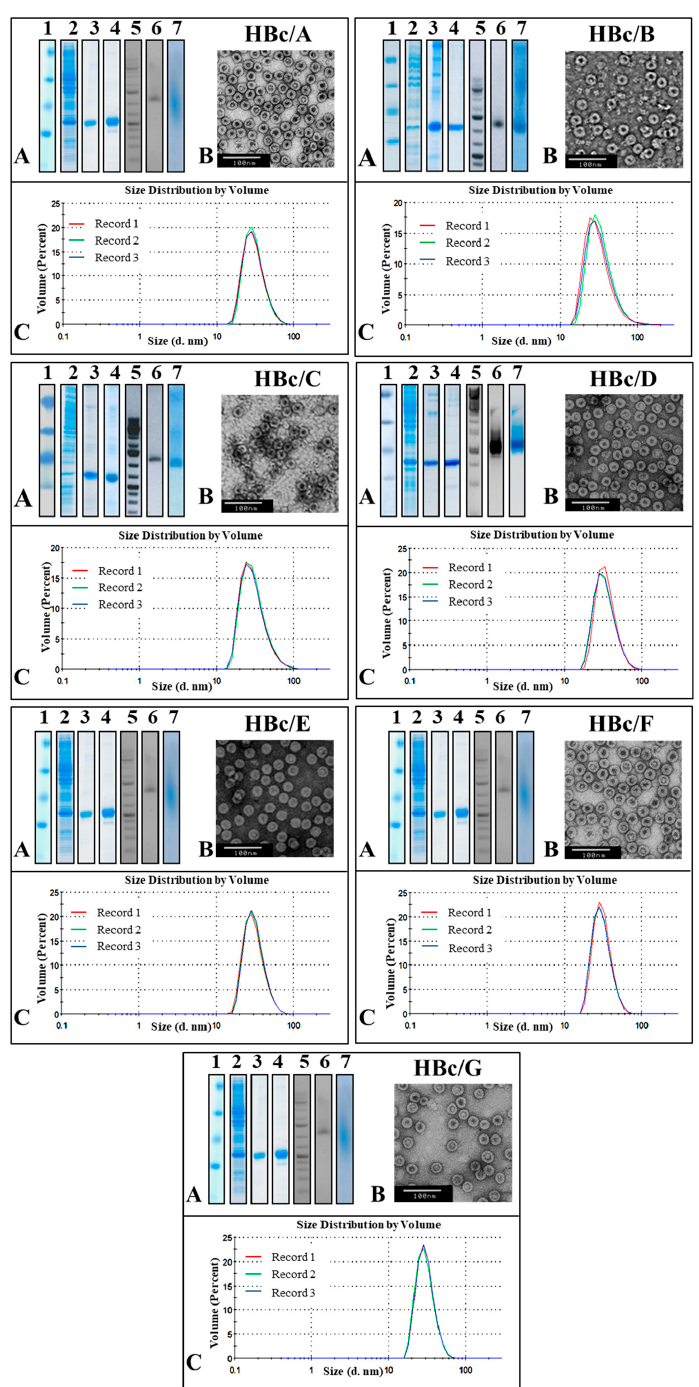
Figure 3. Representation of the purification process for virus-like particles (VLPs) formed by HBc from different HBV genotypes. ( A ) 1 – 4 —SDS-PAGE, stained with Coomassie Brilliant Blue R-250: 1 —Protein Molecular Weight Marker (26612, Thermo Scientific™, Vilnius, Lithuania); 2 — E. coli cells before HBc purification; 3 —the peak fraction from Sepharose 4FF; 4 —peak fraction from Fractogel DEAE (M). Note: HBc/E and HBc/F proteins were purified automatically by two-step chromatography. 5 – 7 —NAGE: 5 —GeneRuller 1 kb DNA Ladder (SM1331, Thermo Scientific™, Vilnius, Lithuania); 6 , 7 —analysis by NAGE of final VLP product: 6 —gel stained with EtBr; 7 —gel stained with Coomassie Brilliant Blue R-250. ( B ) Electron microscopy of purified VLPs. ( C ) DLS analysis of final